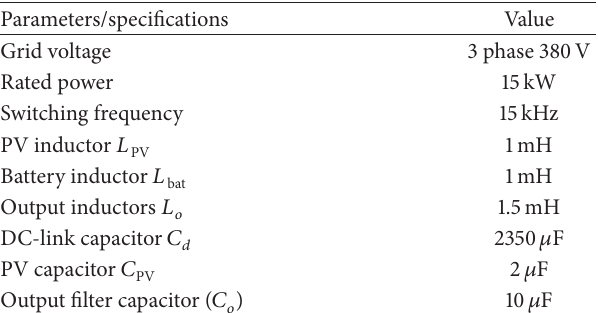
Figure 9: Inverter/rectifier voltage V 𝑎 and current 𝑖 𝑎 ; (a) battery discharging; (b) battery